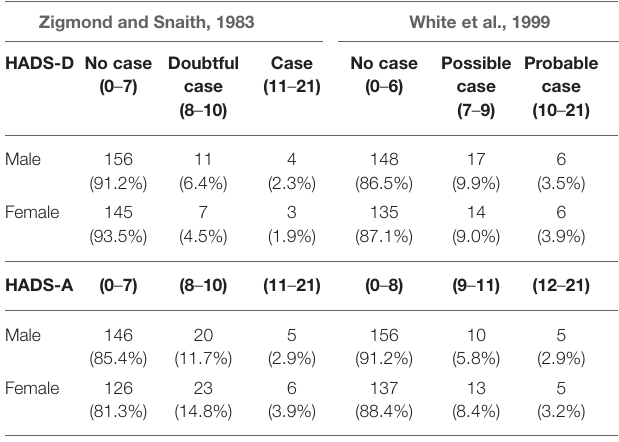
TABLE 4 | Identified cases as well as percentage for anxiety (HADS-A) and depression (HADS-D) depending on cut-off levels as reported by the literature and depending on